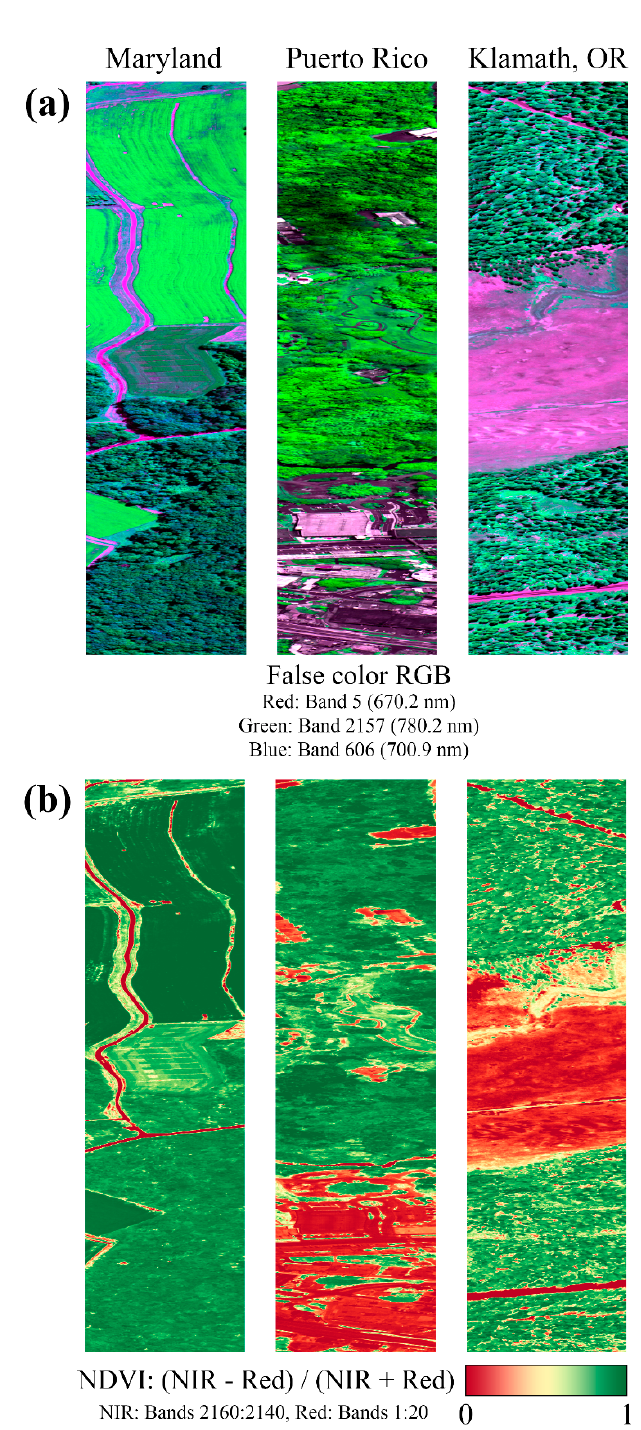
Figure 19. ( a ) False color RGB FIREFLY images (greens: vegetated targets; purples / pinks: non-vegetated targets); ( b ) NDVI FIREFLY images. Note that NDVI successfully removes the cloud shadows and shading from structure visible in the false color images.